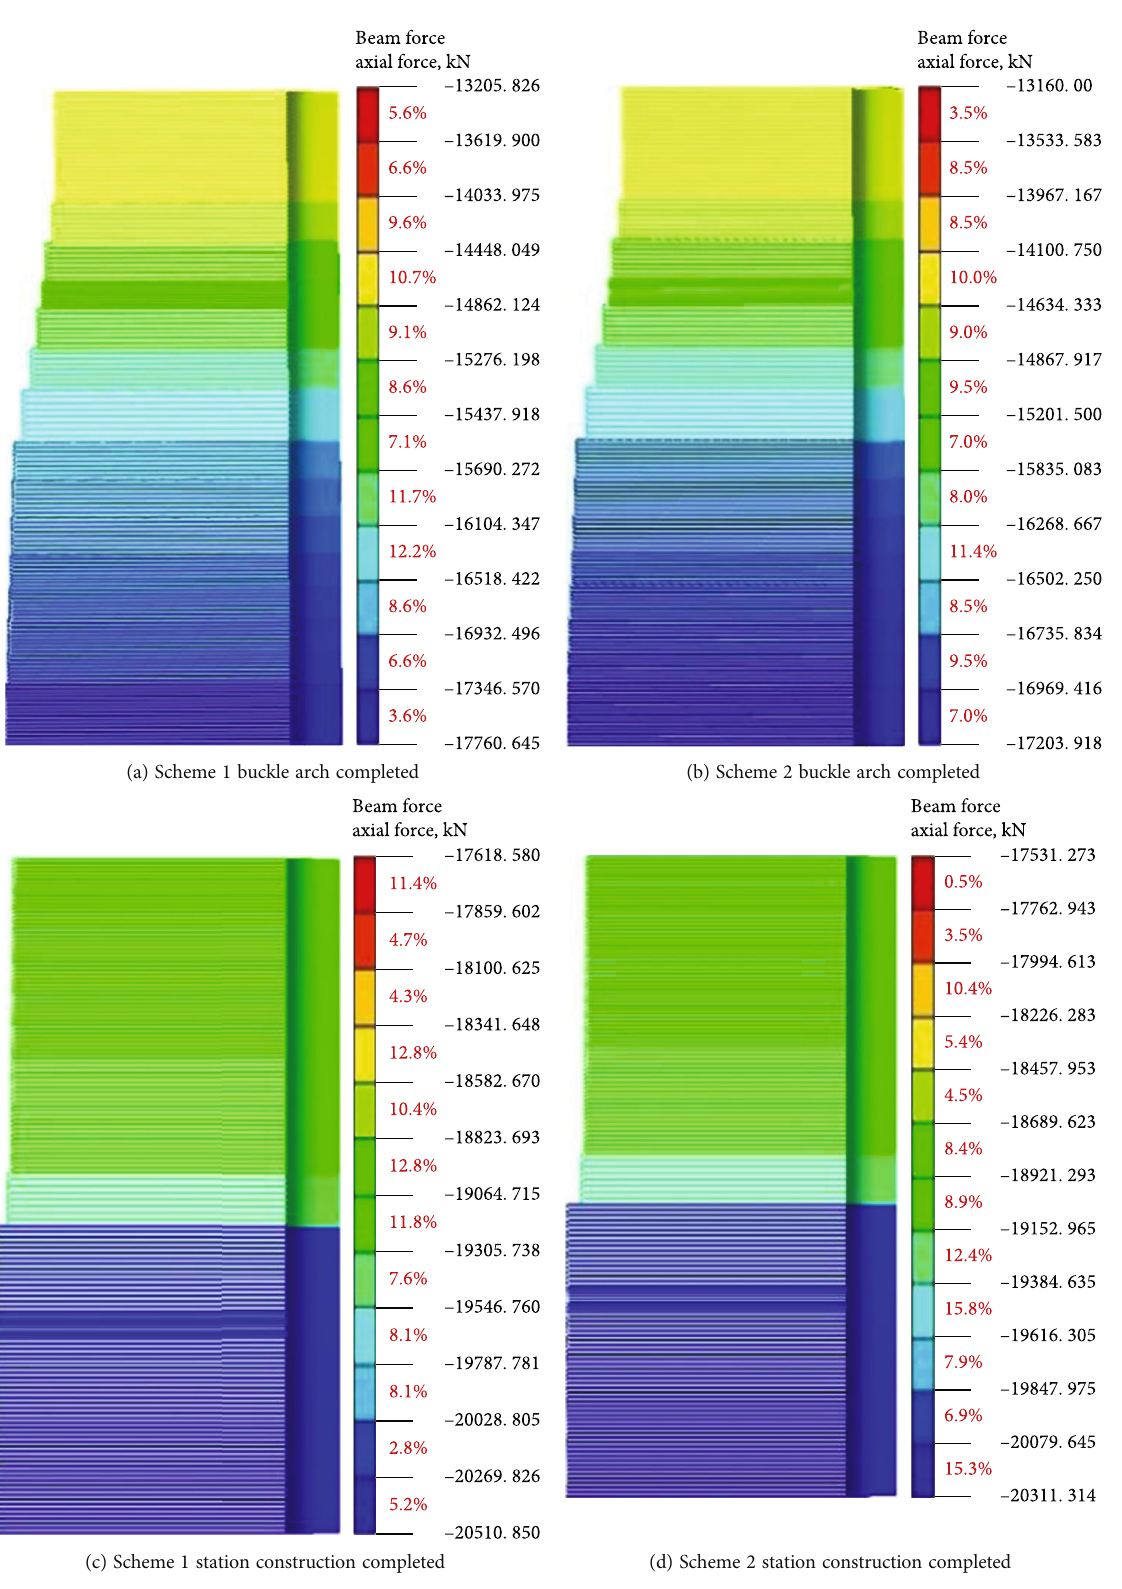
Figure 13: Contrast cloud diagram of the axial force of the central column in schemes 1 and